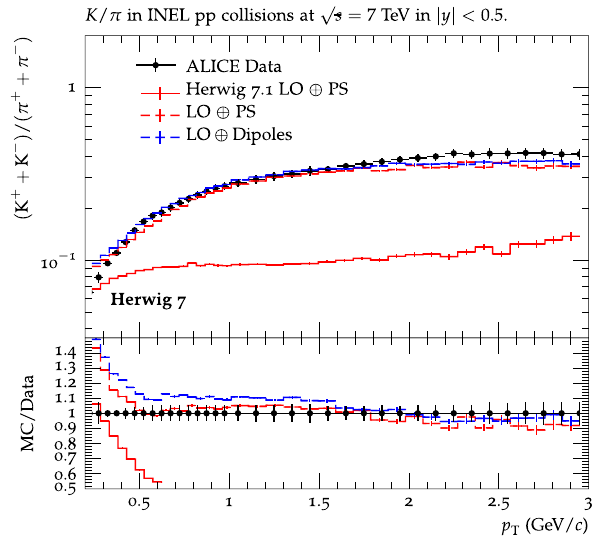
Fig. 9 The K to π ratio in inelastic events in comparison with ALICE data